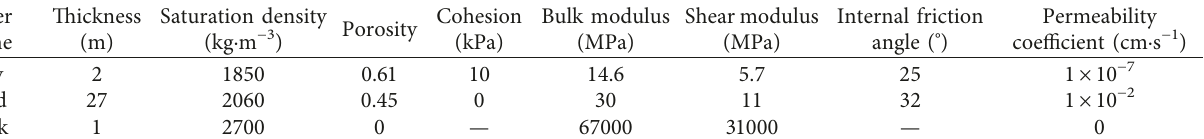
Table 1: Soil parameters of the free field.